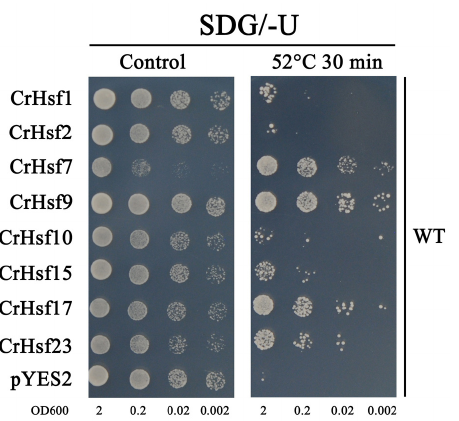
Figure 12. The heat stress tolerance confirmation (52 °C 30 min) of the eight CrHsf genes heteroex- pression in yeast wild type strain (WT). Yeast cultures were adjusted to OD600 = 2, and small por- tions of the yeast cultures were incubated at 52 °C for 30 min, and then were moved to a 30 °C environment before being spotted on SDG/-Ura medium (without any chemical stress factors) for the thermotolerance confirmation. The corresponding yeast spots growing on SDG/-Ura plates without heat stress were used as the control. The plates were incubated for 2–5 days at 30 °C. The images are representative of three independent experiments.